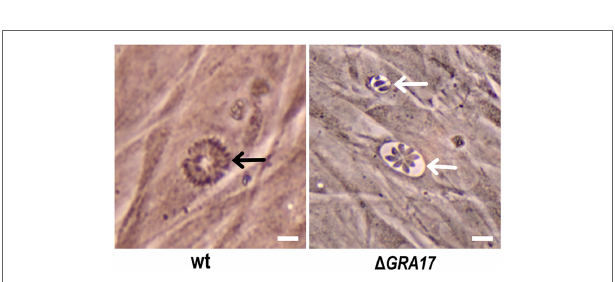
FigUre 2 | Phenotypic analysis of Δ GRA17 -infected human foreskin fibroblast cells. Δ GRA17 mutant developed deformed parasitophorous vacuoles with limited parasite proliferation capability (white arrows) compared to the normal intra-vacuolar tachyzoite’s growth and vacuole’s morphology exhibited by the wt strain (black arrow), indicating the successful deletion of the GRA17 gene. Scale bars, 10 µm.